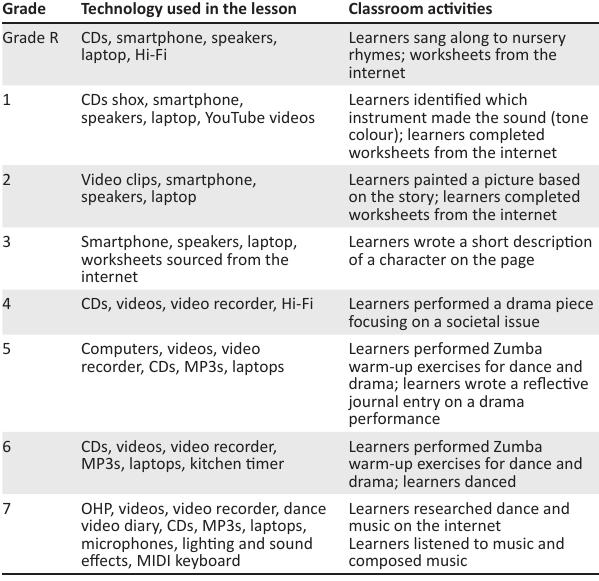
TABLE 2: A summary of the teachers’ use of technology in the